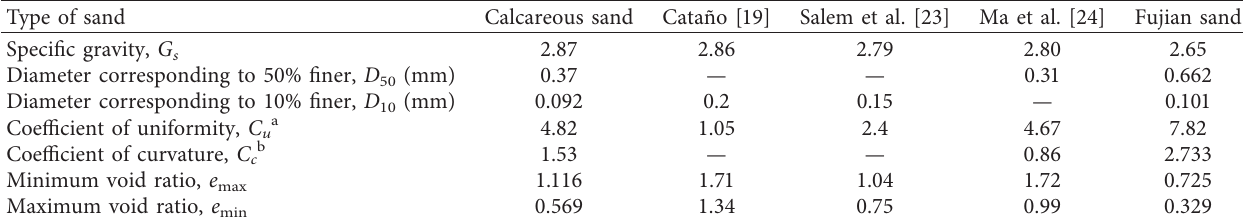
Table 1: Physical properties of various calcareous and siliceous sands.